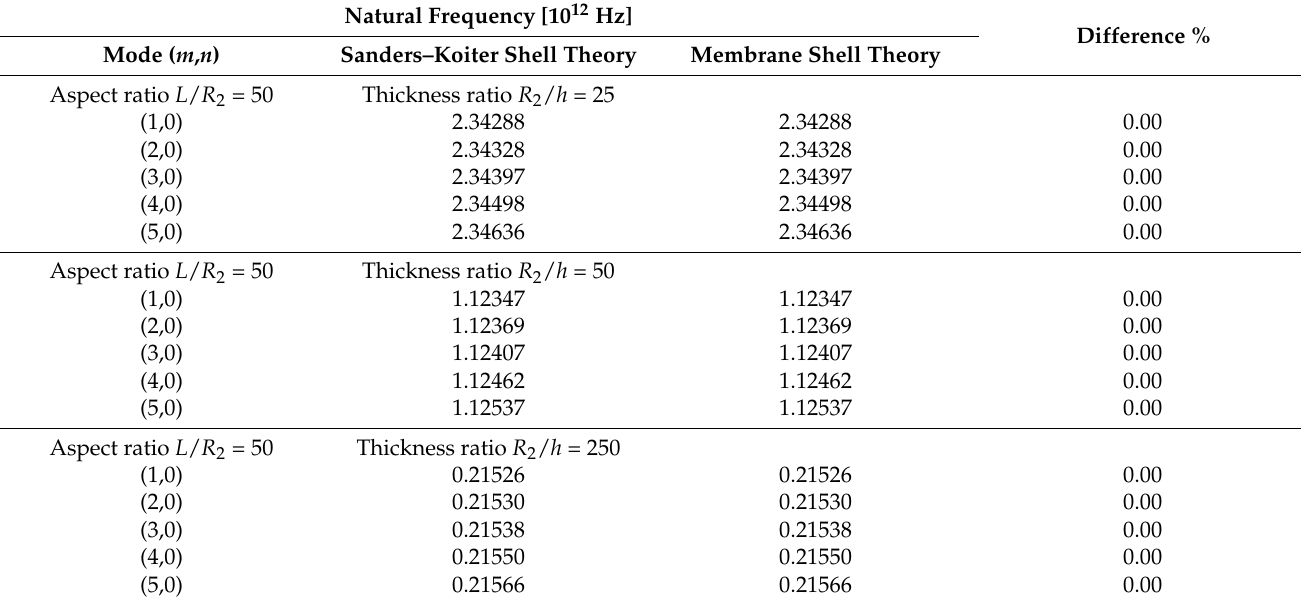
Table 4. Simply supported DWCNT with aspect ratio L / R 2 = 50 and thickness ratios R 2 / h = (25,50,250). Axisymmetric modes ( n = 0). Comparisons between Sanders–Koiter and membrane shell theories.